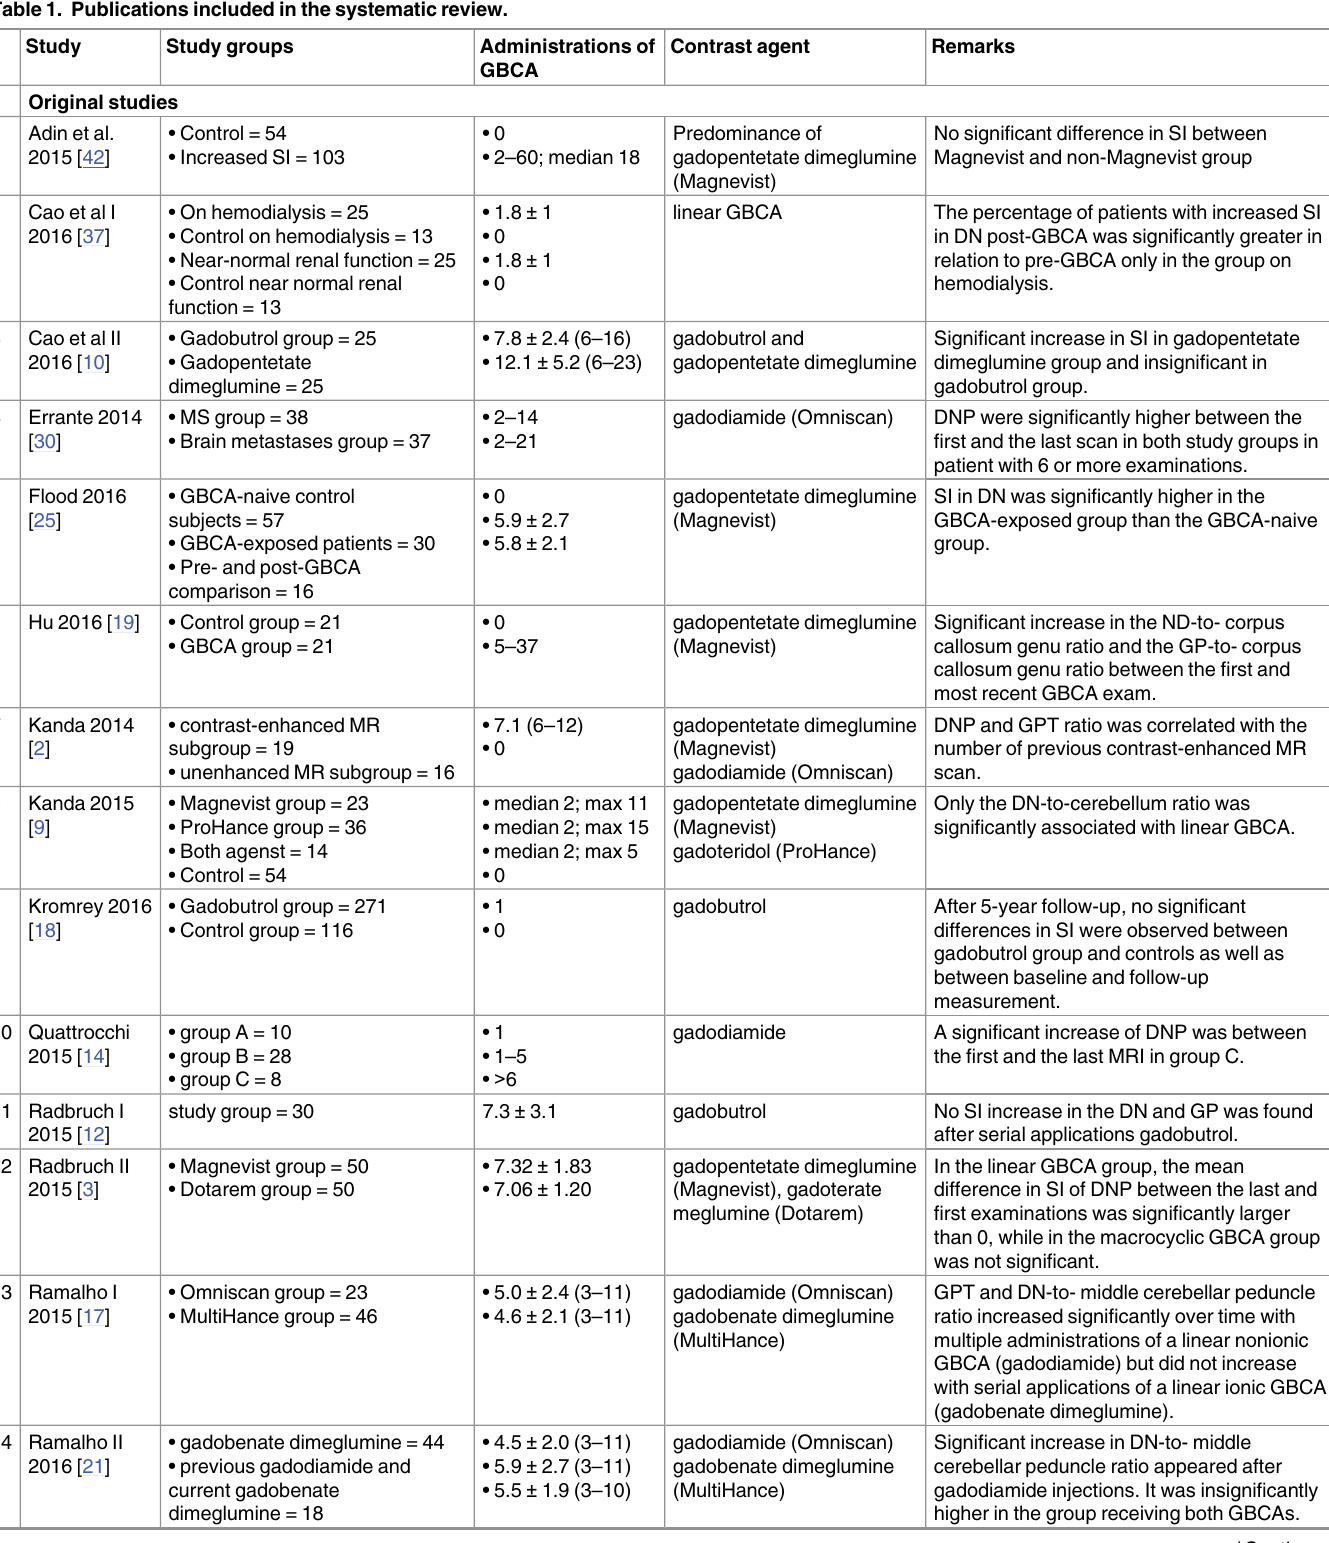
Table 1. Publications included in the